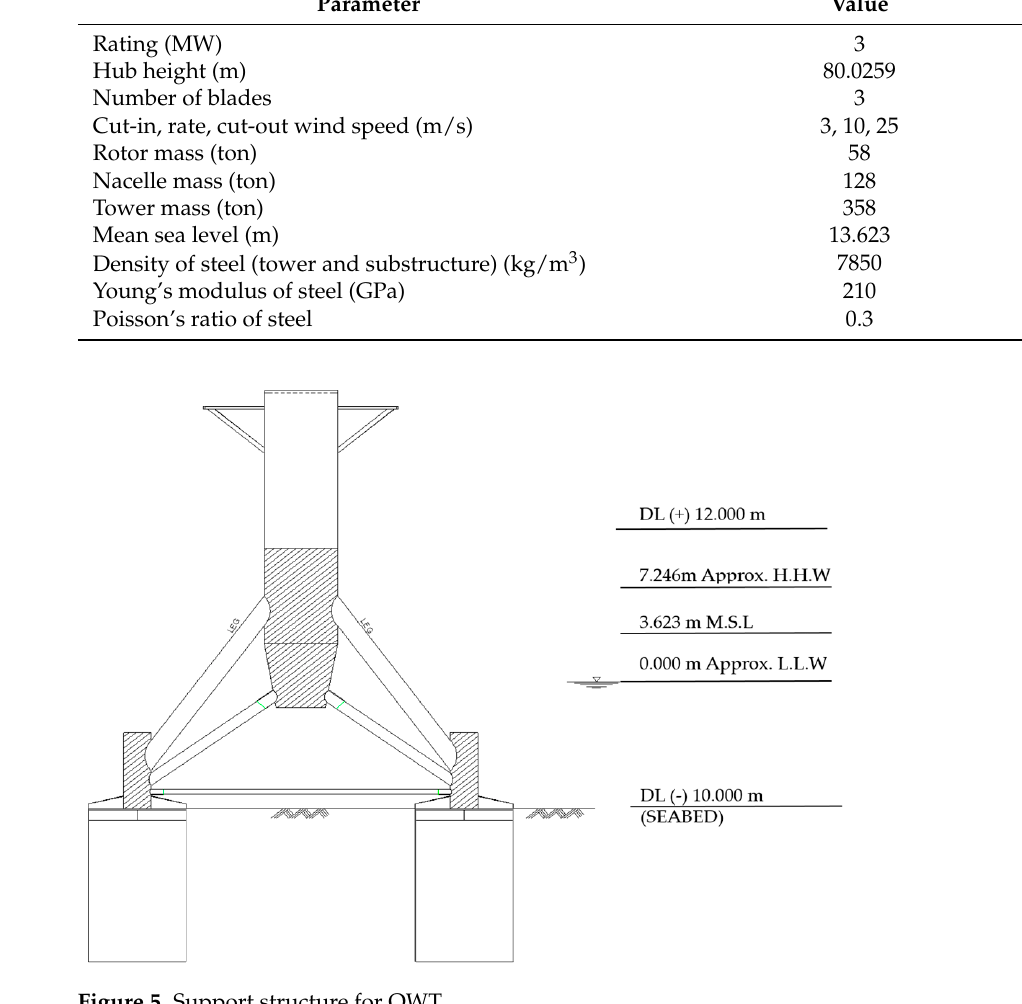
Figure 5. Support structure for OWT. Table 3. Soil